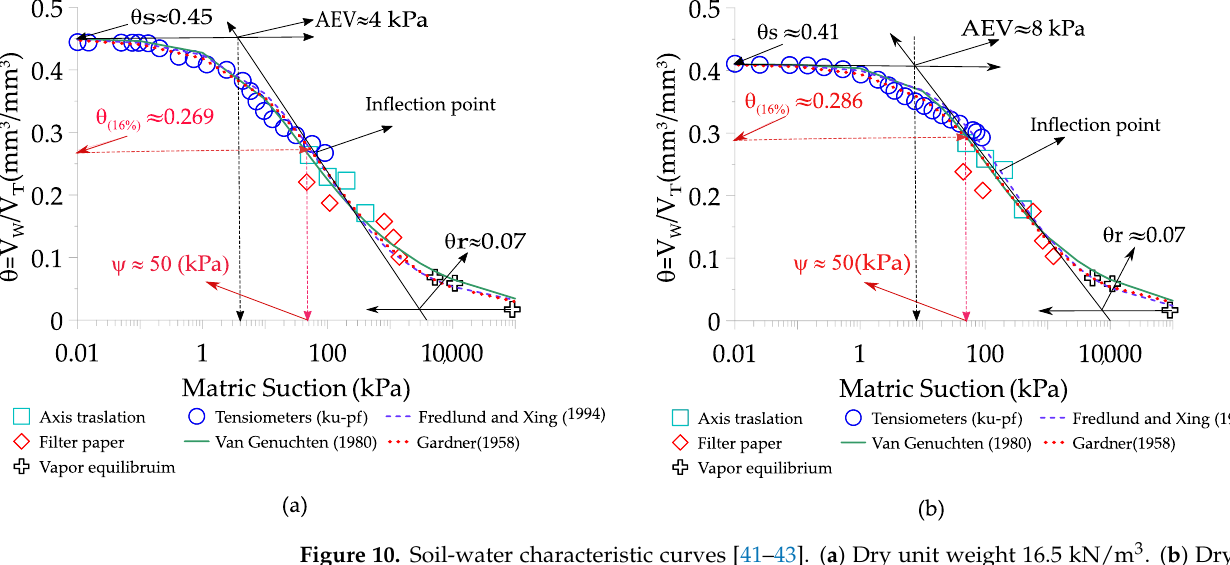
Figure 10. Soil-water characteristic curves [41–43]. ( a ) Dry unit weight 16.5 kN/m 3 . ( b ) Dry unit weight 17.5 kN/m 3